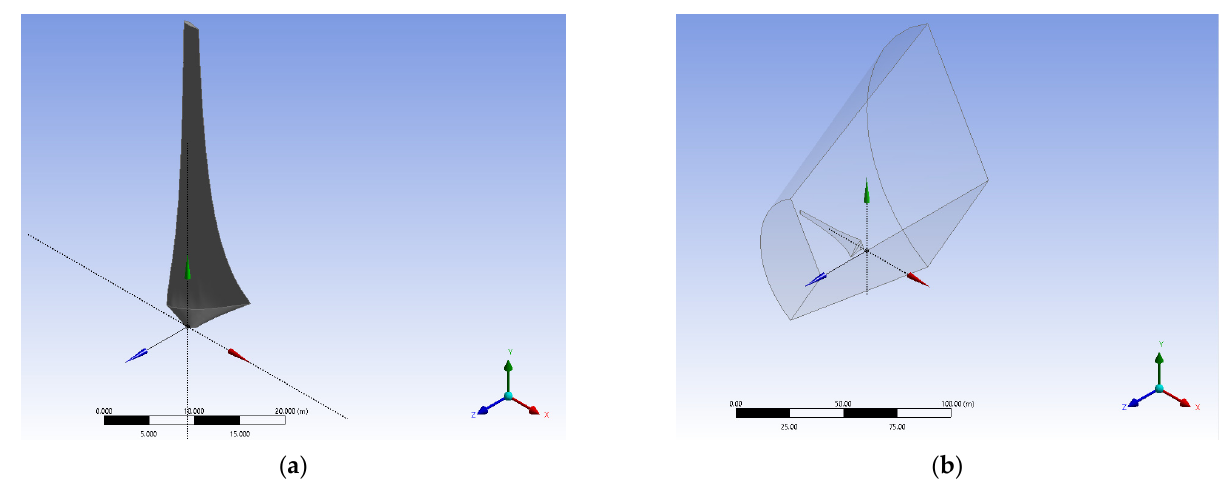
Figure 2. ( a ) Optimum blade constructed with the NREL S809 airfoil; ( b ) Computational domain over the blade.